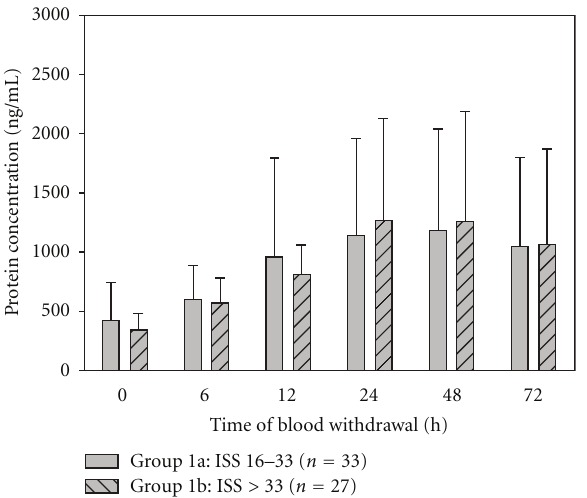
Figure 5: Patients after major trauma (ISS > 33) and patients after moderate injury (ISS ≤ 33) showed nearly equal mean serum levels of TIMP-1 in the early posttraumatic period over 72 hours. There were no significant di ff erences found between these two groups. Data were analyzed by Mann-Whitney Rank Sum test and presented by mean ± standard error of the mean.